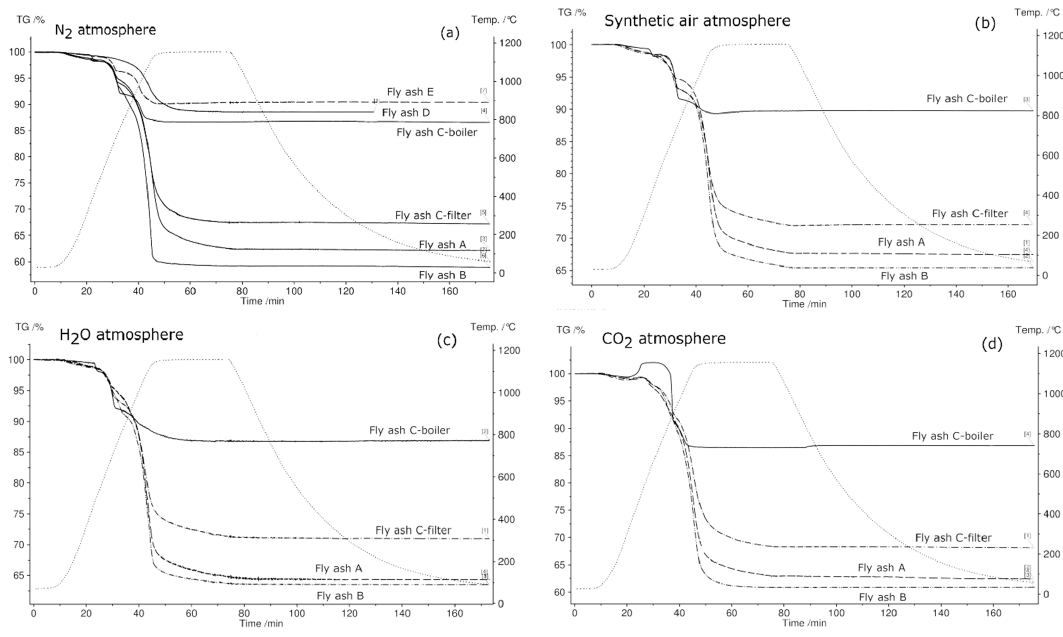
Figure 9. Comparison of thermogravimetric (TG) curves of fly ash samples in N 2 ( a ), synthetic air ( b ), H 2 O ( c ), and CO 2 ( d ) in the temperature range 30 °C–1150 °C.